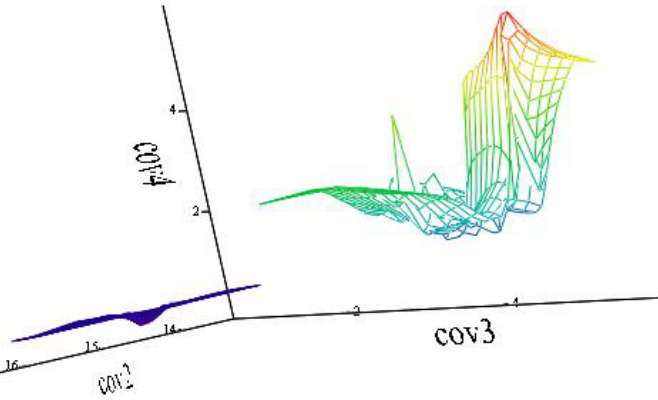
Figure 11. The covariance values of the selected components of the legitimate tra ffi c (color plane) and